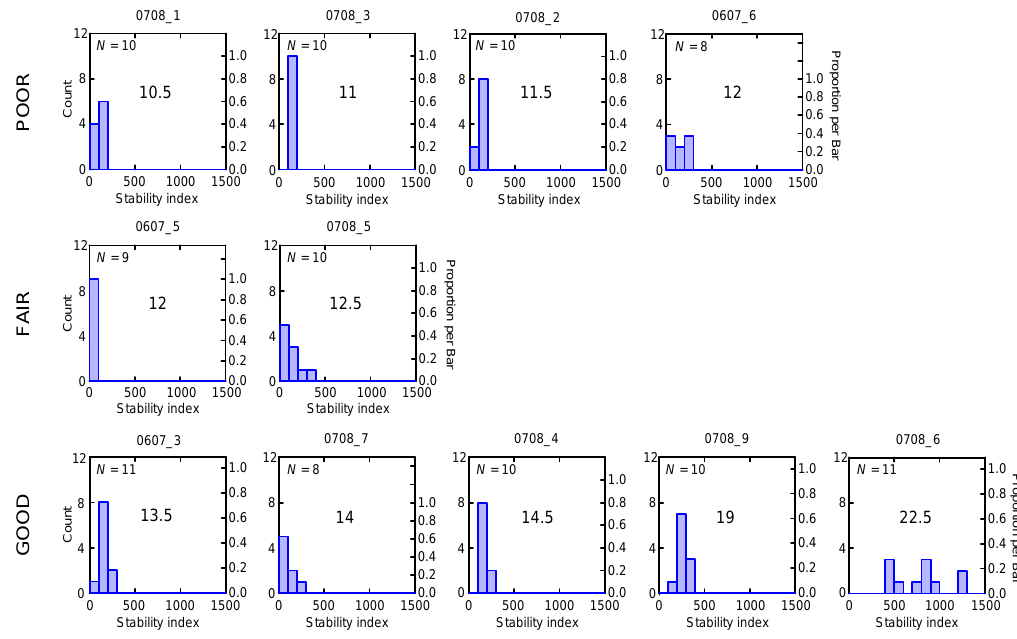
Figure 5. Distributions of stability index for the 11 slopes sampled during winters 2006–2007 and 2007–2008. Only stability derived from those SMP measurements with concurrent CT test are shown. Median CT score is indicated in the middle of each histogram. Slopes are ordered with regard to slope stability (“POOR”, “FAIR”, “GOOD”) and within rows based on median CT score. N varies between 8 and 11.